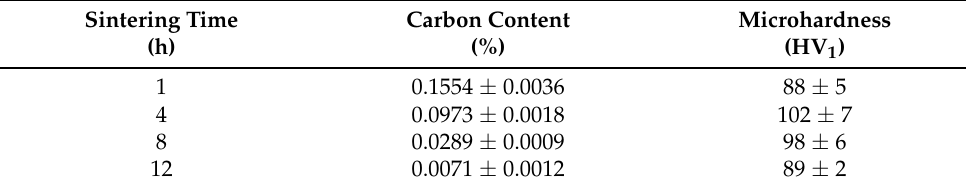
Table 3. Carbon content and microhardness in samples sintered under N 2 -10%H 2 -0.1%CH 4 atmosphere. Sintering